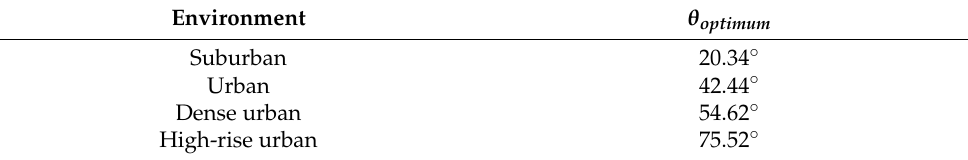
Table 1. Values of optimal elevation angle of each environment.